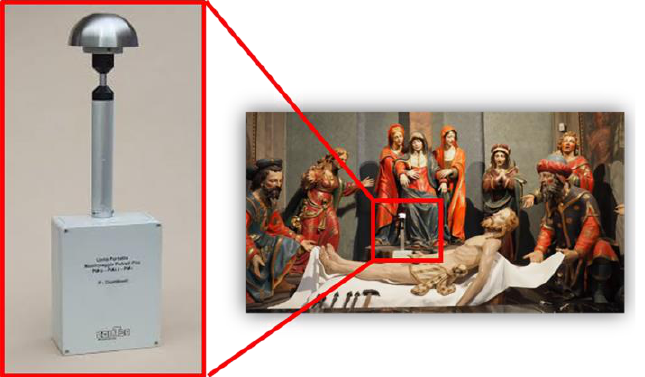
Figure 11. P-Dust Monit positioned in one of the main chapels close to the sculptural group of the Deposition .